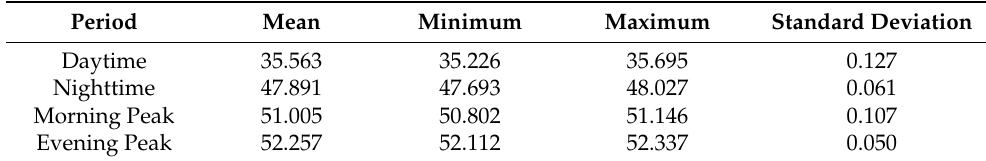
Table 9. Summary statistics of NO 2 exposure (μg/m 3 ).